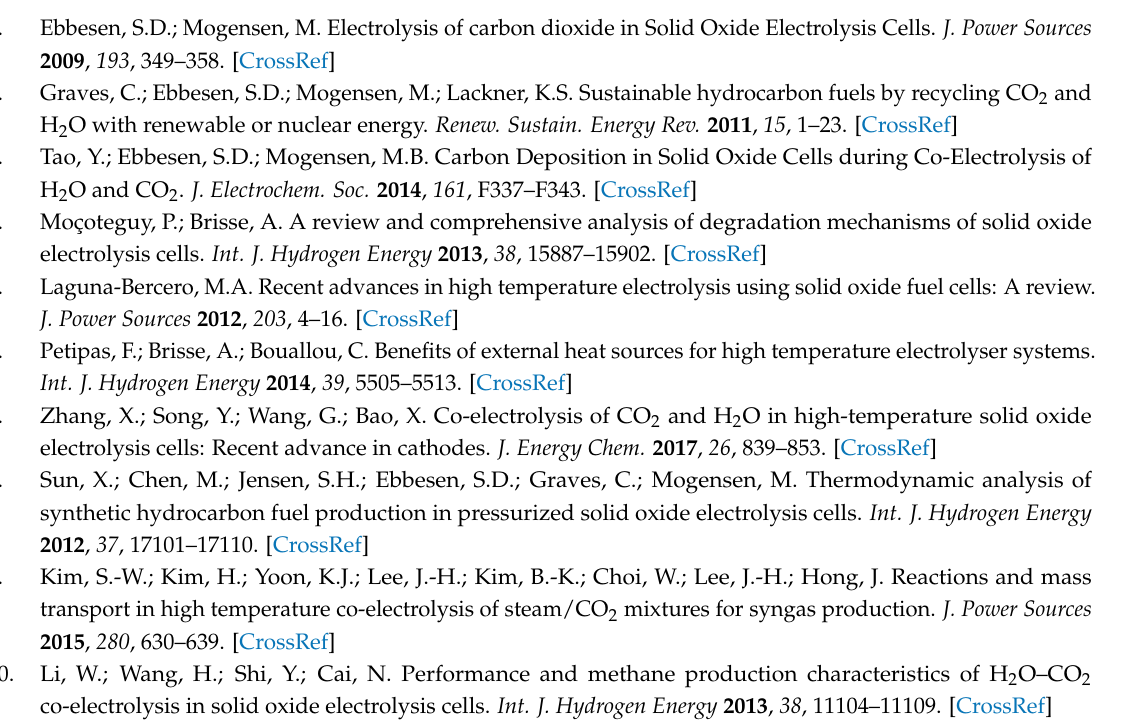
Figure S1. Kinetic study of the R.W.G.S. reaction on the nickel mesh ( (cid:4) ), Ni/GDC with Ni mesh ( (cid:108) ) and Ni/GDC without Ni mesh ( (cid:52) ), in the range of 800–900 ◦ C, under two different mixtures: ( A ) 24.5% H 2 O − 24.5% CO 2 − 21% H 2 (P H2 /P CO = 0.86) and ( B ) 28% H 2 O − 28% CO 2 − 14% H 2 (P H2 /P CO 2 and F total = 140 cm 3 /min (at STP conditions: 0 ◦ C, 1 atm) in all cases. The loading of Ni/GDC is 11 mg/cm 2